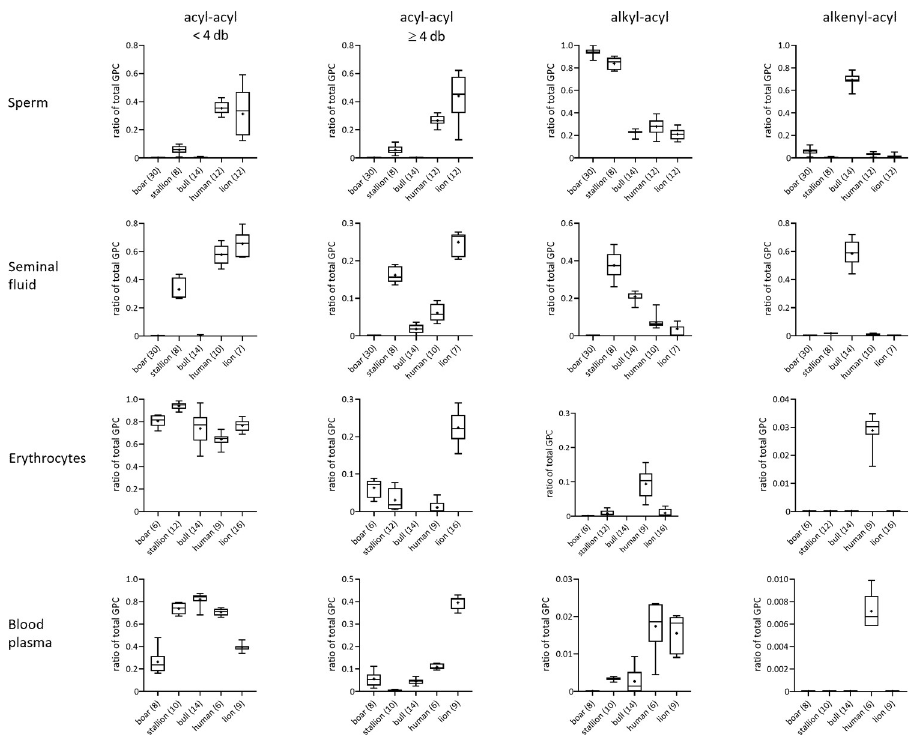
Fig 3. Relative amounts of glycerophosphatidylcholine (GPC) species in sperm, seminal fluid, erythrocytes and blood plasma samples. Extracted lipid-containing fractions from sperm, seminal fluid, erythrocytes and blood plasma samples of boar, stallion, bull, man and lion were investigated by MALDI-TOF mass spectrometry. Signal intensities of all GPC from one spectrum were summarized and set to 1. Relative amounts for the categories (I) GPC with two fatty acids bound to the sn- 1 and the sn- 2 position and less than four double bonds in total ( acyl-acyl < 4db ), (II) GPC with two fatty acids bound to the sn- 1 and the sn- 2 position and more than or equal four double bonds in total ( acyl-acyl � 4 db ), (III) GPC with an ether bond in position sn- 1 to an alkyl group and a fatty acid bound to the sn- 2 position ( alkyl- acyl ) and (IV) GPC with an ether bond in position sn- 1 to an alkenyl group (plasmalogens, alkenyl-acyl ) were calculated for each sample. The number of samples investigated is given in brackets after the species names. Data over all samples from one species are depicted as box plots with whiskers representing the smallest and the largest value. The line represents the median, the mean is represented by